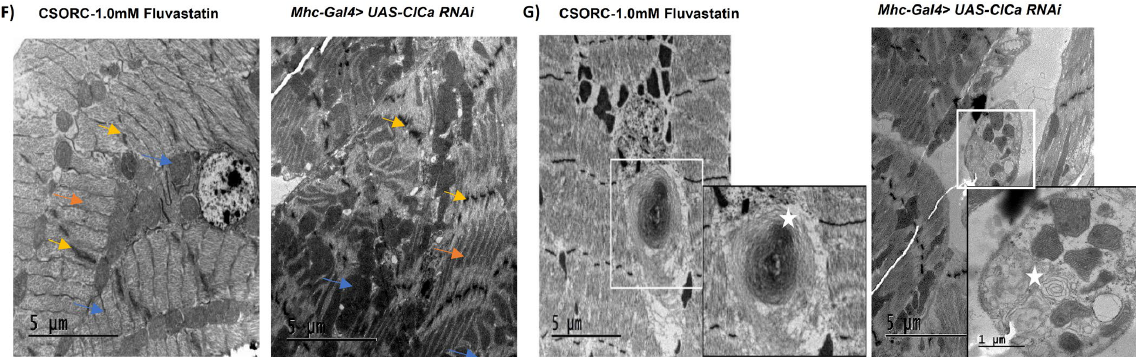
Figure 6. ClC-a knockdown in muscles lowered climbing movement and induced myopathy-like phenotypes in flies. ClC-a knockdown was carried out using the UAS-Gal4 system where ClC-a RNAi knockdown group is Mhc-Gal4>UAS-ClC-a RNAi and control groups are Mhc-Gal4>w1118 and w1118>UAS-ClC-a RNAi . Male flies, aged for five days after eclosion and fed with food, were collected for the experiments. ( A ) The histograms indicate the activity counts/30 min, total activity accounts and activity while awake using DAMs where the number of flies is indicated in brackets. ( B1 – B3 ) The histograms indicate the average moves, speed and positions for a total six-hour interval on the left and per hour on the right using the Force-Climbing System where the number of flies is indicated in brackets. ( C ) TEM micrographs for the morphology of the longitudinal sections of the skeletal muscles of the femur segment of the legs. ClC-a RNAi knockdown flies show abnormal sarcomere architecture, disoriented, distorted myofibrils and Z-line streaming along with severely fragmented mitochondria of different shapes and sizes in comparison to controls. Orange arrow for Z-line, yellow for sarcomere, black for vacuoles, and blue for mitochondria. ( D ) Using ImageJ software, the sarcomere length, in µ M, was measured in a selected number of TEM micrographs for each group (indicated in brackets). ( E ) Using ImageJ software, we traced the mitochondria area in selected TEM micrographs. The histogram represents the area of mitochondria in µ m 2 where the dots represent the number of mitochondria. ( F ) TEM micrographs illustrate a similar pattern of muscle fibre damage between ClC-a RNAi knockdown flies and CSORC flies fed with 1.0 mM fluvastatin for five days while ( G ) shows the myelin figure (star) in both groups. In each histogram, the bars represent the mean values ± SEM. The number of samples is indicated in brackets. The Shapiro–Wilk test was used to check normality wherein ( A , D , E ) the statistical difference was calculated using one-way ANOVA with Bonferroni’s multiple comparisons for normally distributed data and Kruskal–Wallis one-way tests for non-parametric data. For ( B1 – B3 ), two-way ANOVA with Bonferroni correction for multiple comparisons test was used. * p ≤ 0.05; ** p ≤ 0.01; *** p ≤ 0.005; **** p ≤